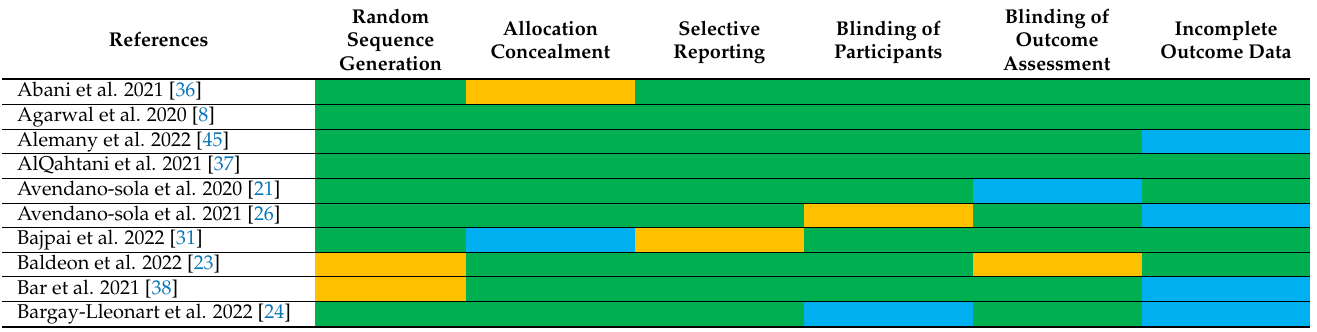
Table 2. Bias risk rating for each